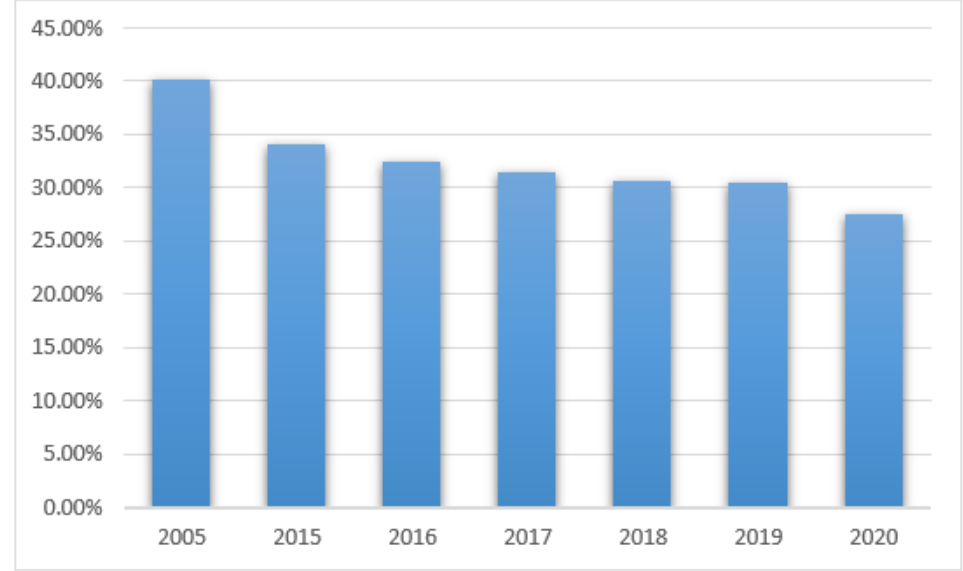
Figure 5. Positive results of mycological tests in PCICU patients in the studied years.